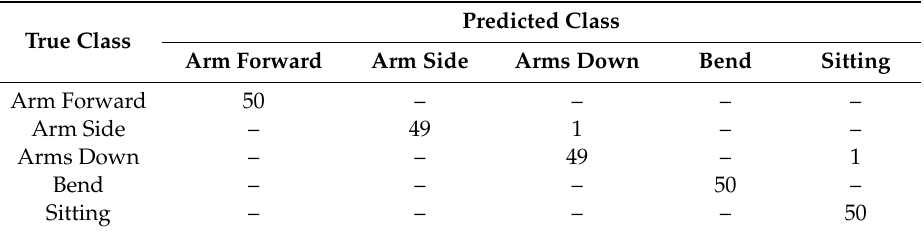
Table 7. Confusion matrix generated from testing all five TISs